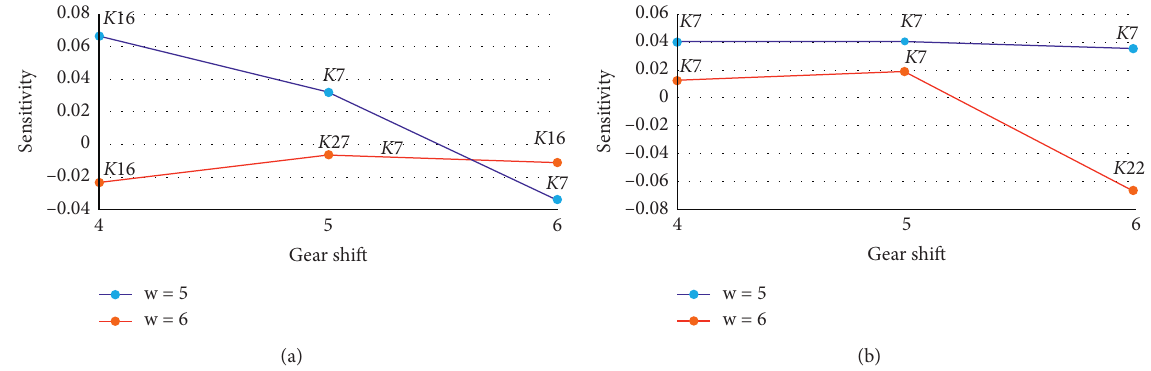
Figure 13: The most sensitive parameters of vibration mode under the 3rd and 4th order from the 3rd to 4th gear. (a) The most sensitive stiffness of the 3rd-order vibration mode. (b) The most sensitive stiffness of the 4th-order vibration